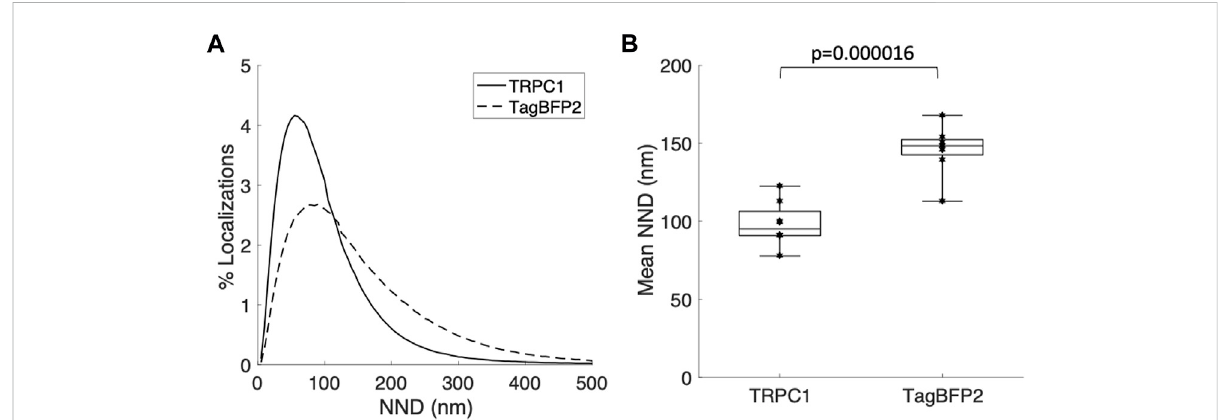
Quanti fi cation ofcolocalizationfrom super-resolution imagesof NRVMs infected with TRPC1-TagBFP2orTagBFP2. (A) Averagedistributionof nearest neighbor distances (NND) of SERCA2 from TagBFP2 in TRPC1-TagBFP2 cells and TagBFP2 control cells. (B) Mean NND in TRPC1-TagBFP2